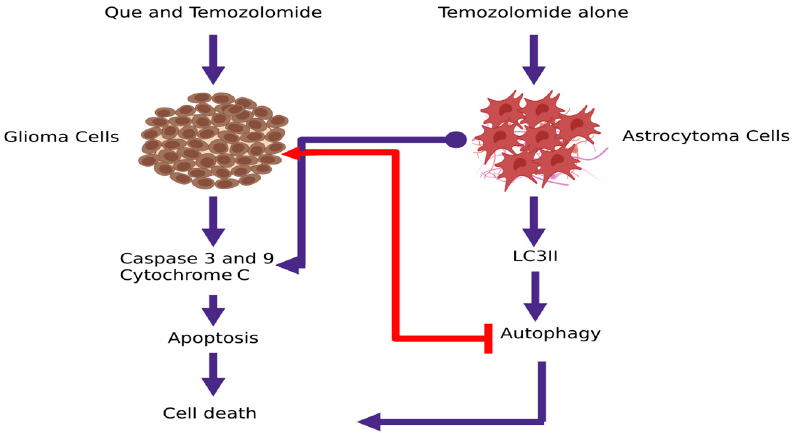
Figure 5. Synergistic cytotoxic effects of Que and temozolomide tested on human glioblastoma multiforme T98G cells and human anaplastic astrocytoma cell line MOGGCCM. Que synergistically enhances temozolomide-mediated apoptosis by cytochrome C release, activation of caspase 3 and 9 and inhibition of Hsp27 and Hsp72 expression that are involved in the prevention of cell death [30]. At a low concentration of temozolomide, Que promotes autophagic effect that indicate an increased level of LC3II, while at a higher temozolomide concentration, autophagy switched to apoptosis [33]; (created with www.biorender.com; 25 February 2023).